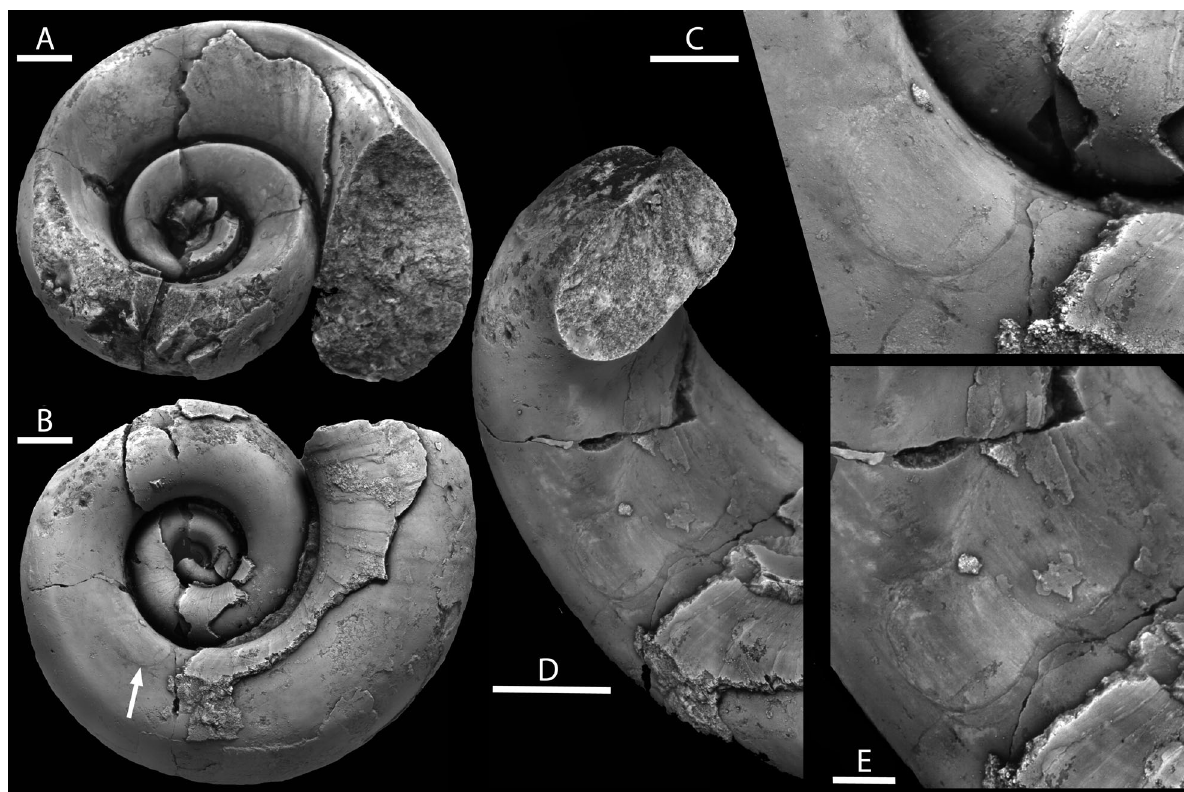
Fig. 2. Lesueurilla cf. helix (Eichwald, 1856), SMNH Mo 70510, internal mould with adherent shell patches; A , oblique apical view; B , C , basal view showing muscle attachment scar (arrow), enlarged in C; D , E , early whorls removed to show figure-of-eight muscle attachment scar. Scale bars: 5 mm (A, B, D); 2 mm (C,